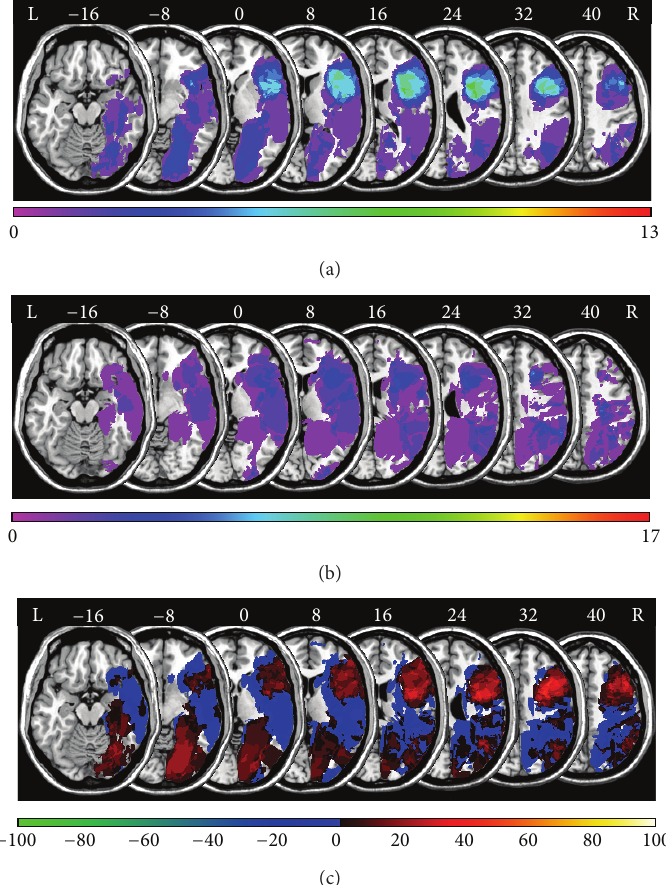
Figure 2: Anatomical results obtained from the lesion subtraction analysis on the number of TMT-B total errors. (a) Overlay lesion plots for those patients who committed two or more total errors ( Mdn = 1) on the TMT-B ( 𝑁 = 13 ). The number of overlapping lesions is illustrated by color, from violet ( 𝑁 = 1 ) to red ( 𝑁 = 13 ). (b) Overlay lesion plots for those patients who committed less than two total errors on the TMT-B ( 𝑁 = 17 ). The number of overlapping lesions is illustrated by color, from violet ( 𝑁 = 1 ) to red ( 𝑁 = 17 ). (c) Overlay plots of the subtracted superimposed lesions of the patients with two or more total errors on the TMT-B minus the patients with less than two total errors on the TMT-B . Colors code increasing frequencies from dark-red (difference from 1% to 20%) to white-yellow (difference from 81% to 100%), indicating regions damaged more frequently in patients who committed relatively many total errors on the TMT-B . The colors from dark-blue (difference from − 1 to − 20%) to light-green (difference from − 81 to − 100%) indicate regions damaged more frequently in patients who committed relatively few total errors on the TMT-B